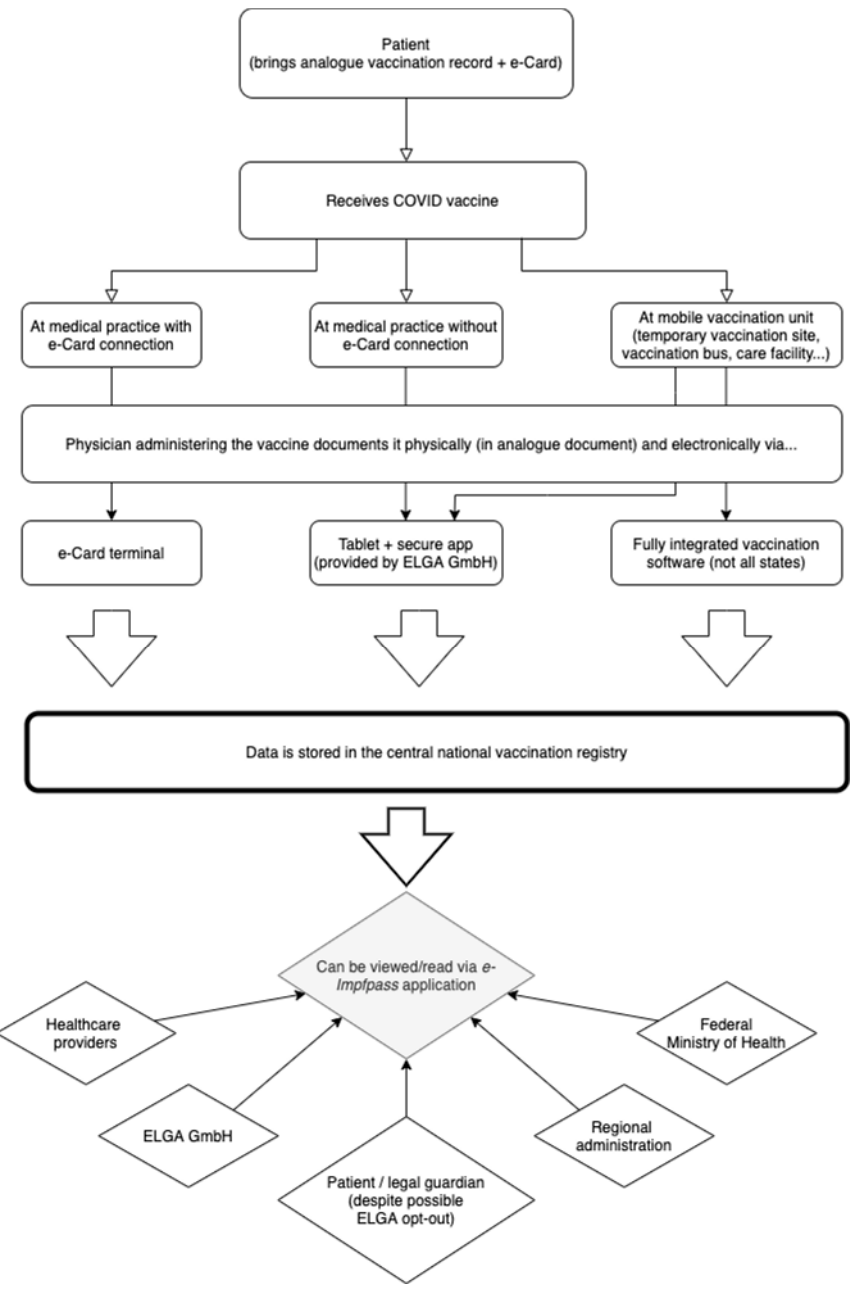
Figure 1. Immunization data governance in Austria. The lead-up to planning and implementing the digital vaccination record was in- formed by lessons learned from several epidemiological crisis moments, including the H1N1 pandemic in 2009. According to one interviewee (ITV 2), this crisis, along with the introduction of new vaccines such as the vaccine against Human Papilloma Virus (HPV) demonstrated to healthcare administrations the need to have a more precise overview of the number of vaccine doses administered, preferably in a centralized system. Another significant factor were the increased occurrences of measles in Austria, starting with a